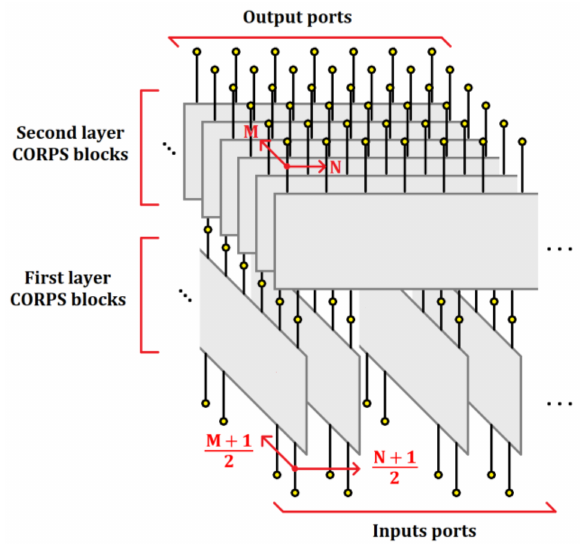
Figure 2. Block diagram of the beamforming network for the configuration 3 using 4 × 7 CORPS networks.